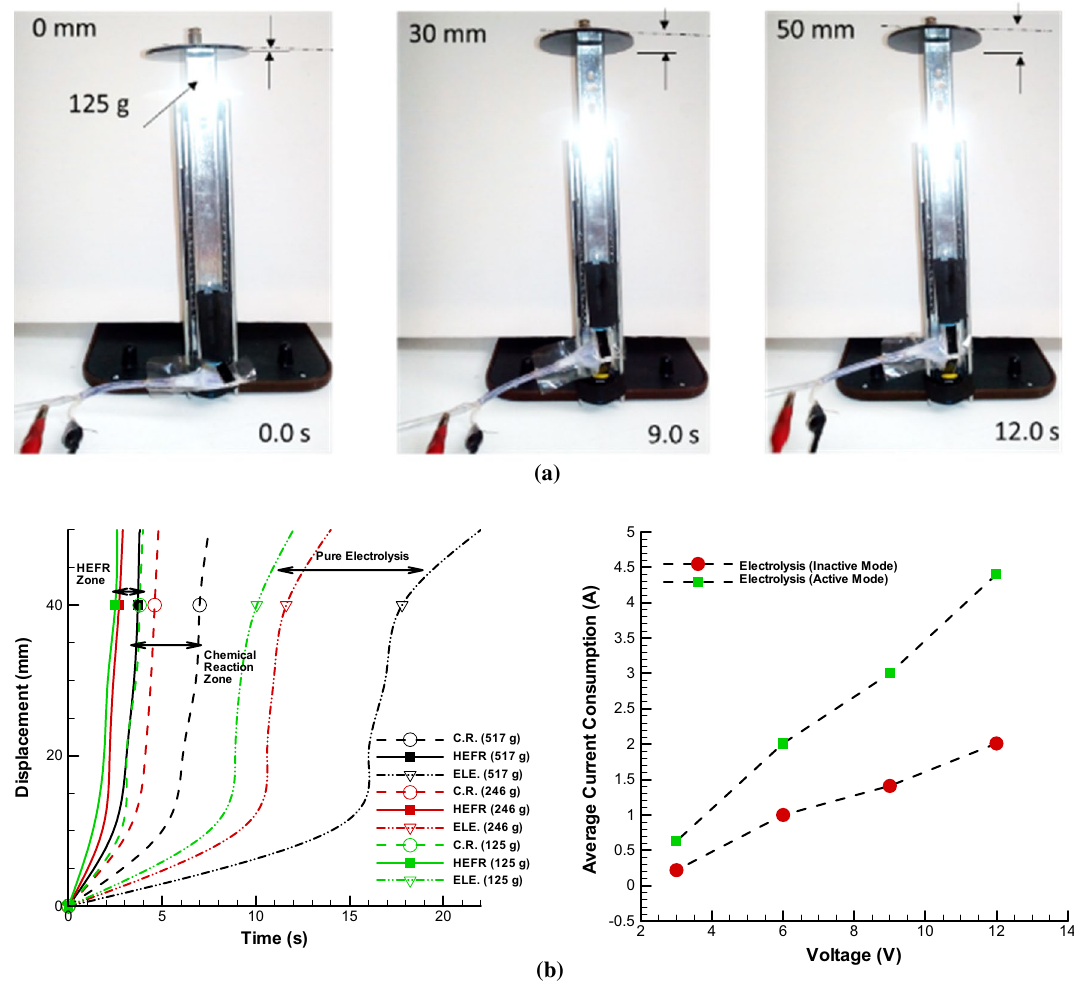
Figure 5. Sliding displacement of single soft skin-solid structure over time. Movement of sliding displacement of inflation tester over time in pure electrolysis mode in 12 v (a) . Plot of displacement over time in modes of pure electrolysis (12 V), chemical reaction and HEFR in different loading condition and average current consumption by changing the voltage for two different active and inactive modes (b)